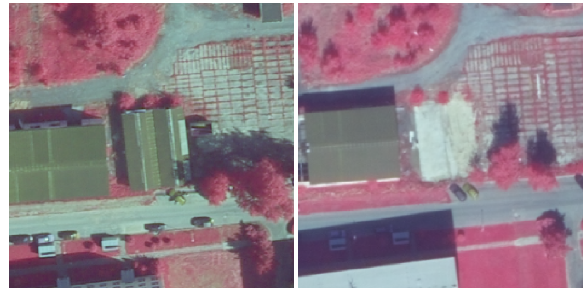
Figure 2. Left: CIR image (2010) Right: CIR image (2012)